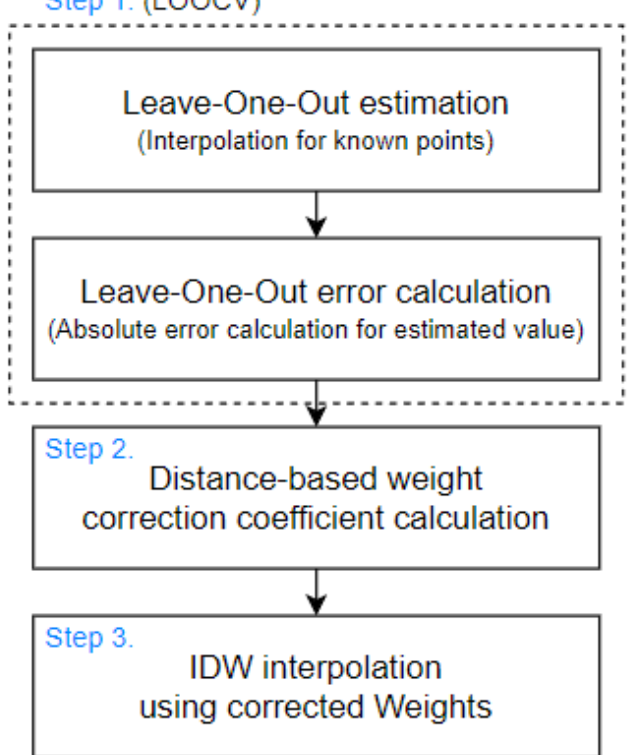
Figure 2. Flow chart of modified inverse distance weight (IDW).